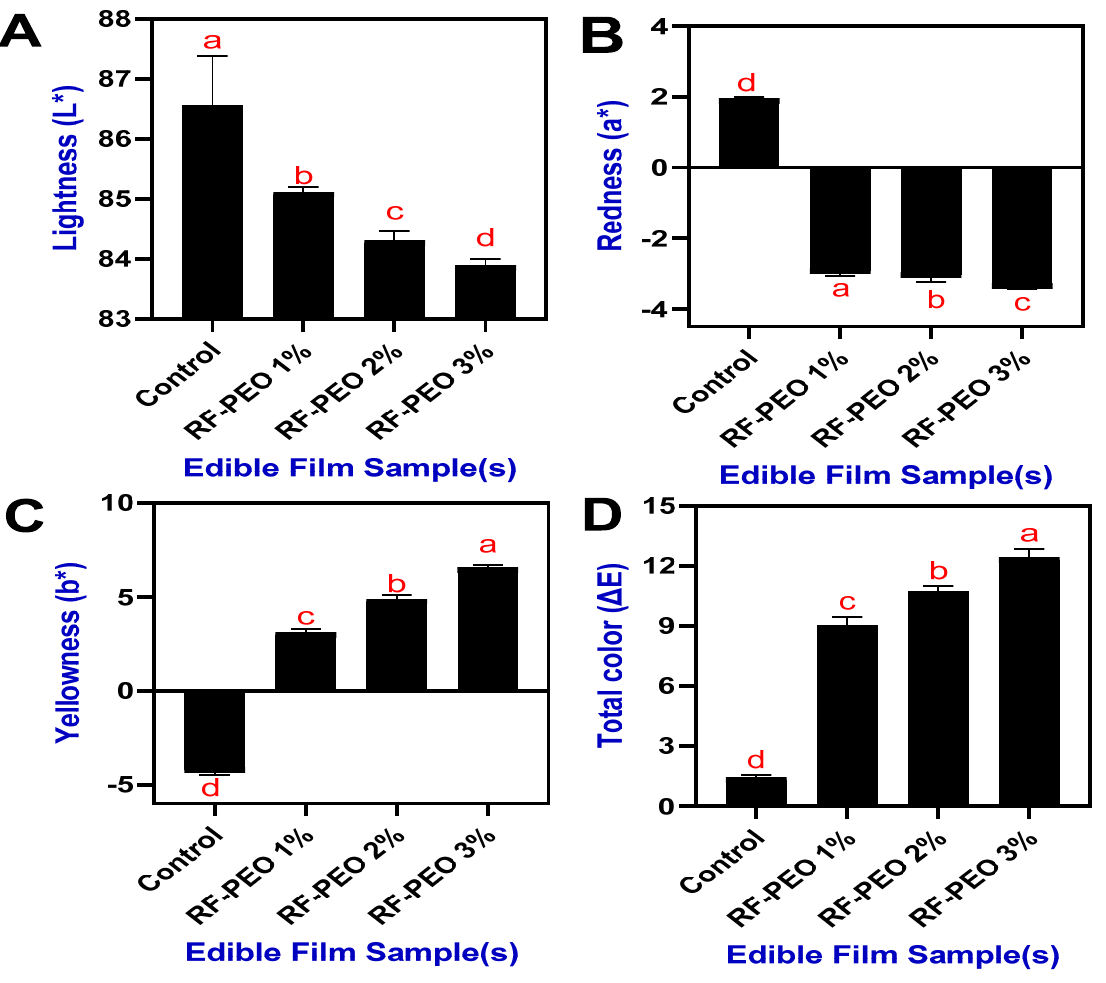
Figure 2. Color characteristics (L* ( A ), a* ( B ), b* ( C ) and ∆ E ( D )) of edible films made of RF-PEO at varying concentrations. The different letters of the alphabet shown on the bar diagram indicate significant differences.